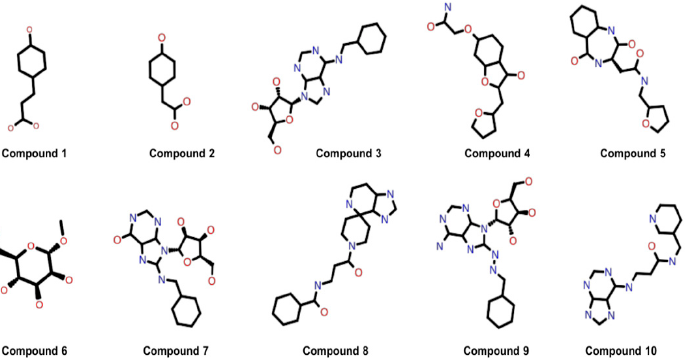
Figure 3. 2D structure of the best ten compounds identified through the refined model structure of the HEV-MTase docking study.